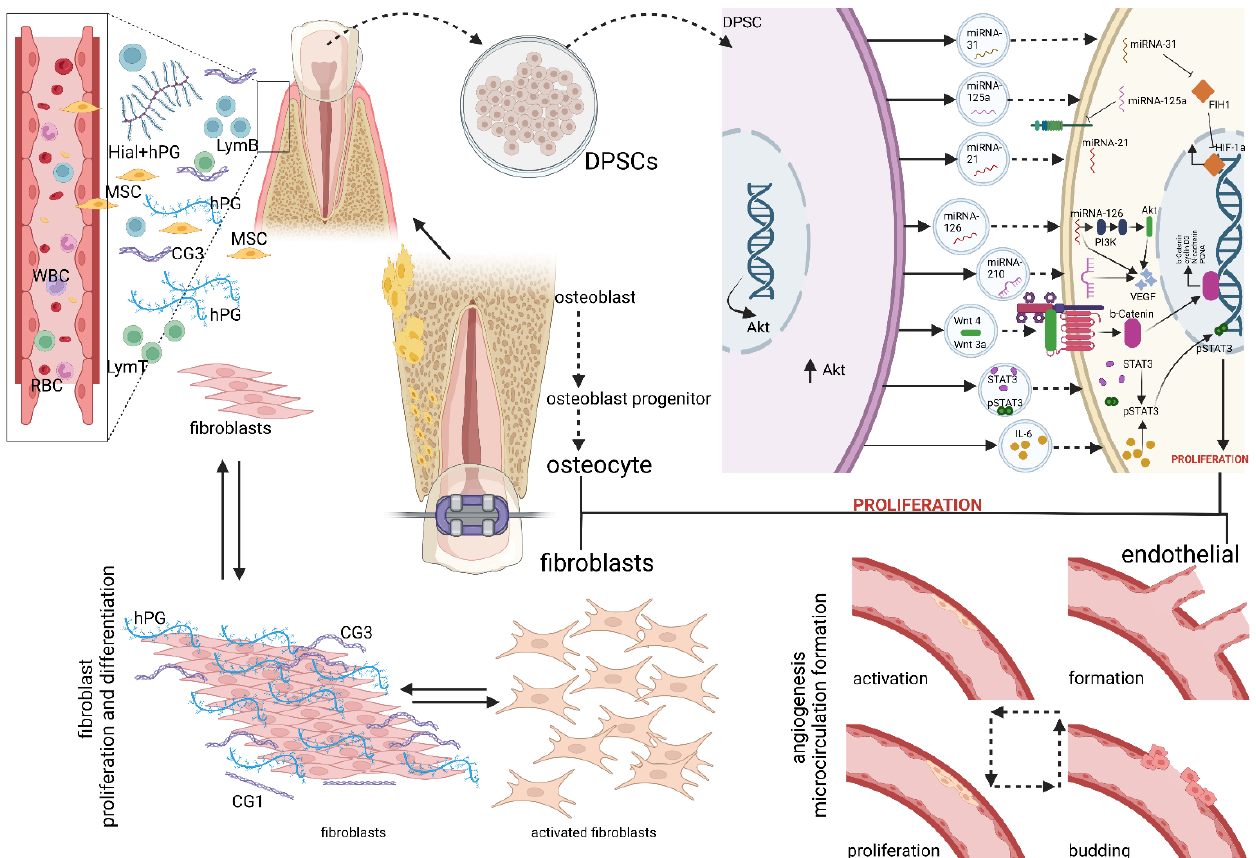
Figure 1. The complex physiological/biological interactions and cellular pathways enabling the clin- ical application of SCs in orthodontics and dentofacial orthopedics (created using BioRender plat-